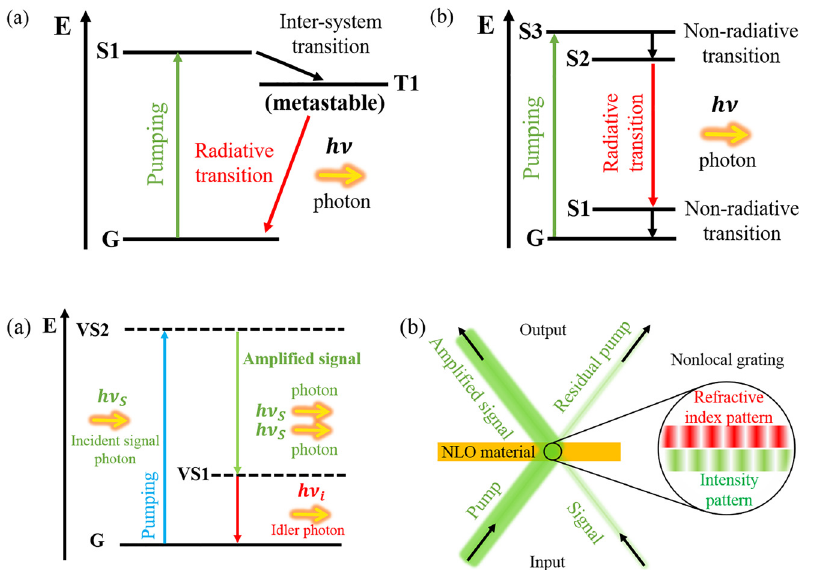
Figure 3: Nonlinear parametric amplification (a) and holographic ampli fi cation of light in TBC con fi guration